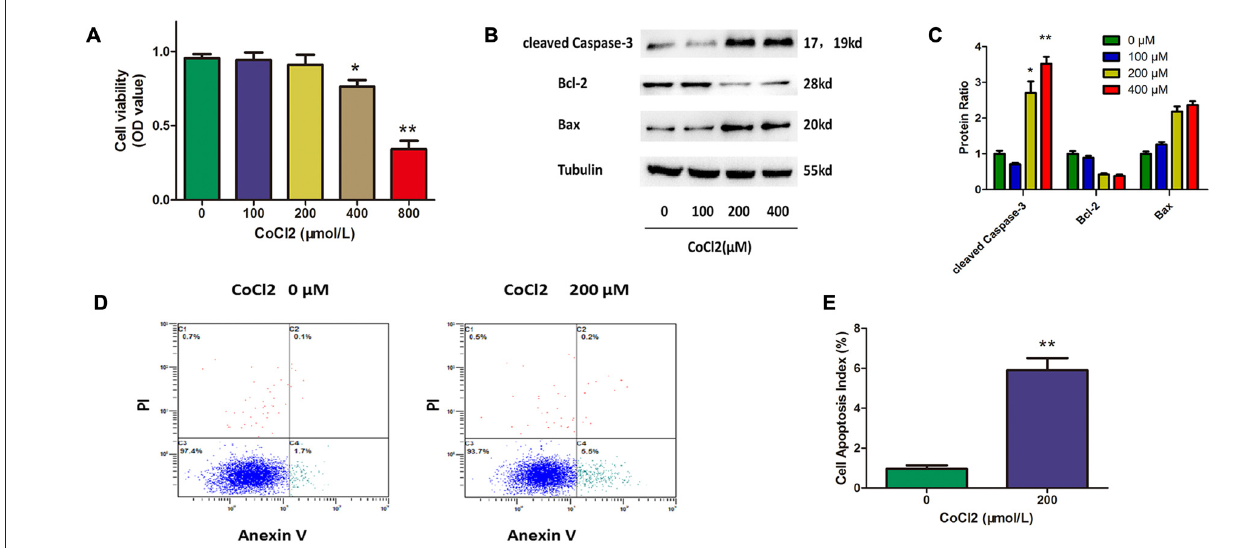
FIGURE 1 | Cobalt chloride (CoCl 2 ) induces retinal ganglion cells (RGCs) apoptosis. (A) Cell viability detected by Cell Counting Kit-8 (CCK-8) assay in RGCs treated with indicated concentrations of CoCl 2 for 24 h. Data are means ± SD of three independent experiments. ∗ p < 0.05, ∗∗ p < 0.01 vs. basal level. (B,C) Expression of cleaved caspase-3, bax and bcl-2 detected by Western blotting in RGCs treated with indicated concentrations of CoCl 2 for 24 h. The corresponding densitometric analyses of the protein bands detected in the immunoblots and normalized to the signal of α -tubulin are also shown. The level of protein in each group was expressed as the value relative to the control. Data are means ± SD of three independent experiments. ∗∗ p < 0.01, compared with the control. (D,E) Cell apoptosis detected by Annexin V and propidium iodide (PI) staining methods in RGCs treated with indicated concentrations of CoCl 2 for 24 h. The C3 quadrant (Annexin V − /PI − ), C4 quadrant (Annexin V + /PI − ) and C2 quadrant (Annexin V + /PI+) indicate the percentage of viable cells, apoptotic cells and necrotic cells, respectively. The percentage of apoptotic cells following CoCl 2 treatment compared with the control group. Values represent the mean ± SD of three independent experiments. ∗∗ P <